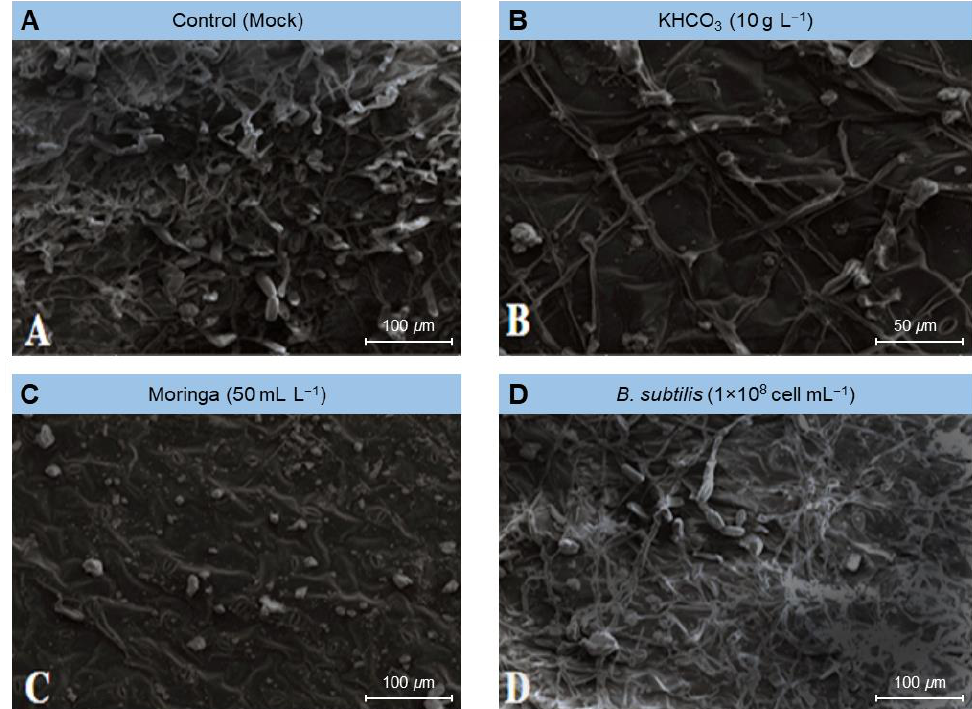
Figure 4. Effect of the most promising treatments on the mycelium density and conidia formation of Erysiphe betae , the causal agent of powdery mildew on sugar beet using scanning electron microscopy (SEM). ( A ) mock-treated plants (tap water), ( B ) plants treated with 10 g L −1 Potassium bicarbonate, ( C ) plants treated with 50 mL L −1 Moringa seeds extract, and ( D ) plants treated with a cell suspension of Bacillus subtilis (1 × 10 8 cell mL −1 ).